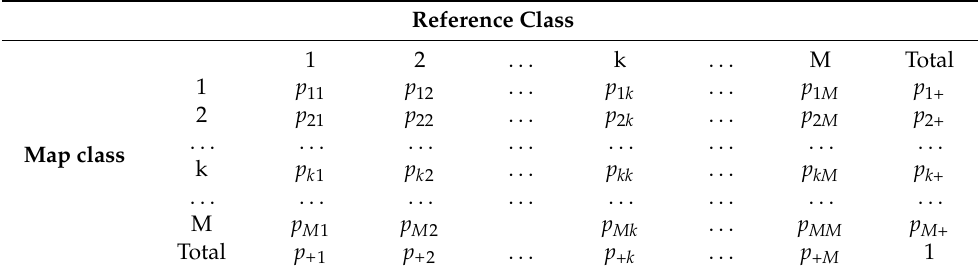
Table 2. Population error matrix for land-cover data with M